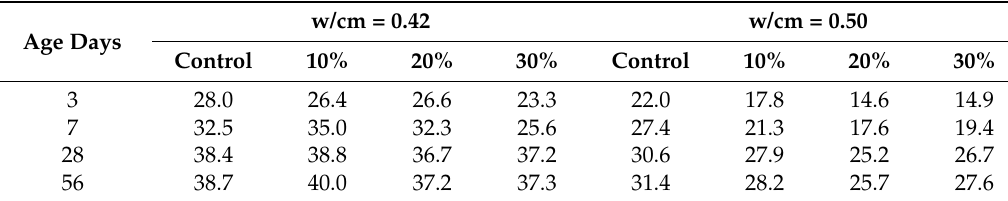
Table 5. Compressive strength development (MPa).